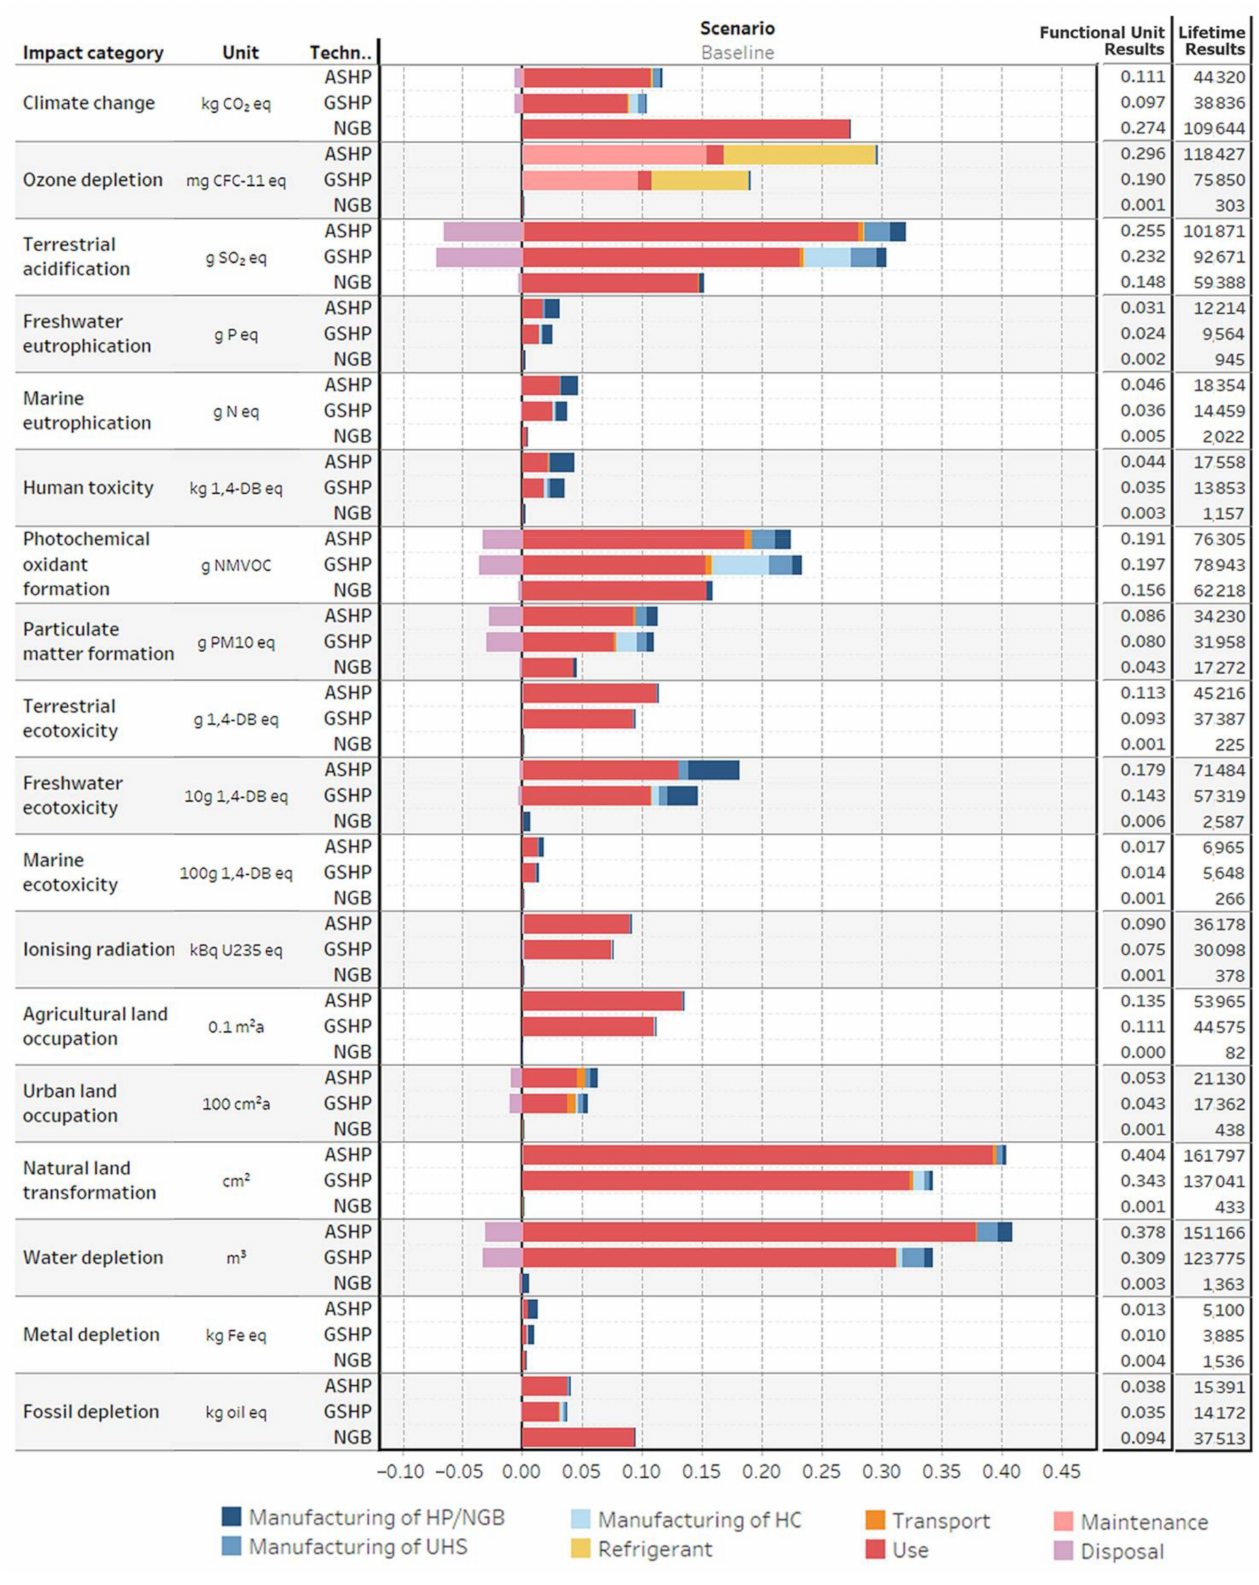
Figure 2. Lifecycle environmental impacts of heat pumps and gas boilers for baseline scenario (HP: Heat pump, NGB: Gas boiler, UHS: Underfloor heating system, HC: Heat